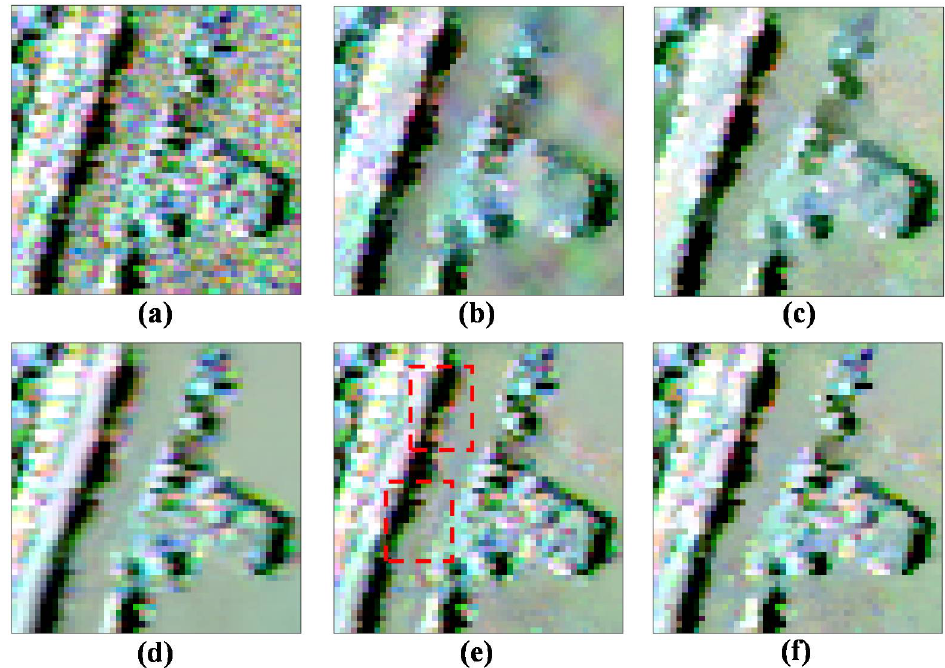
Figure 7. Denoising results of different filtering methods using SAR580-Convair C-band data. ( a ) Original data. ( b ) Refined Lee filter. ( c ) IDAN filter. ( d ) Pretest filter. ( e ) NL-SAR filter. ( f ) The proposed ANLM filter.